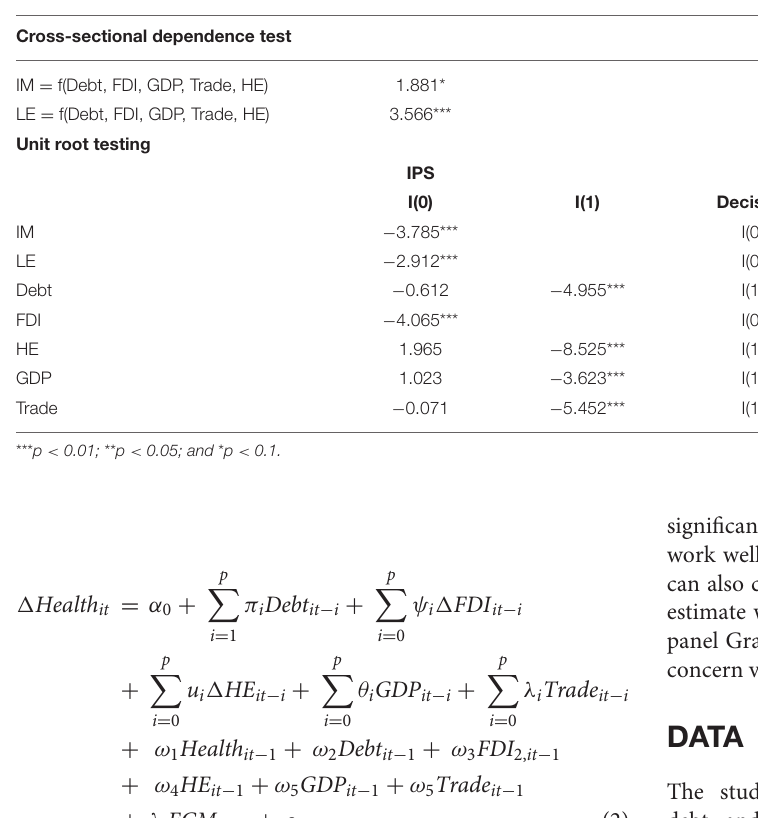
TABLE 2 | Cross-sectional dependence and unit root